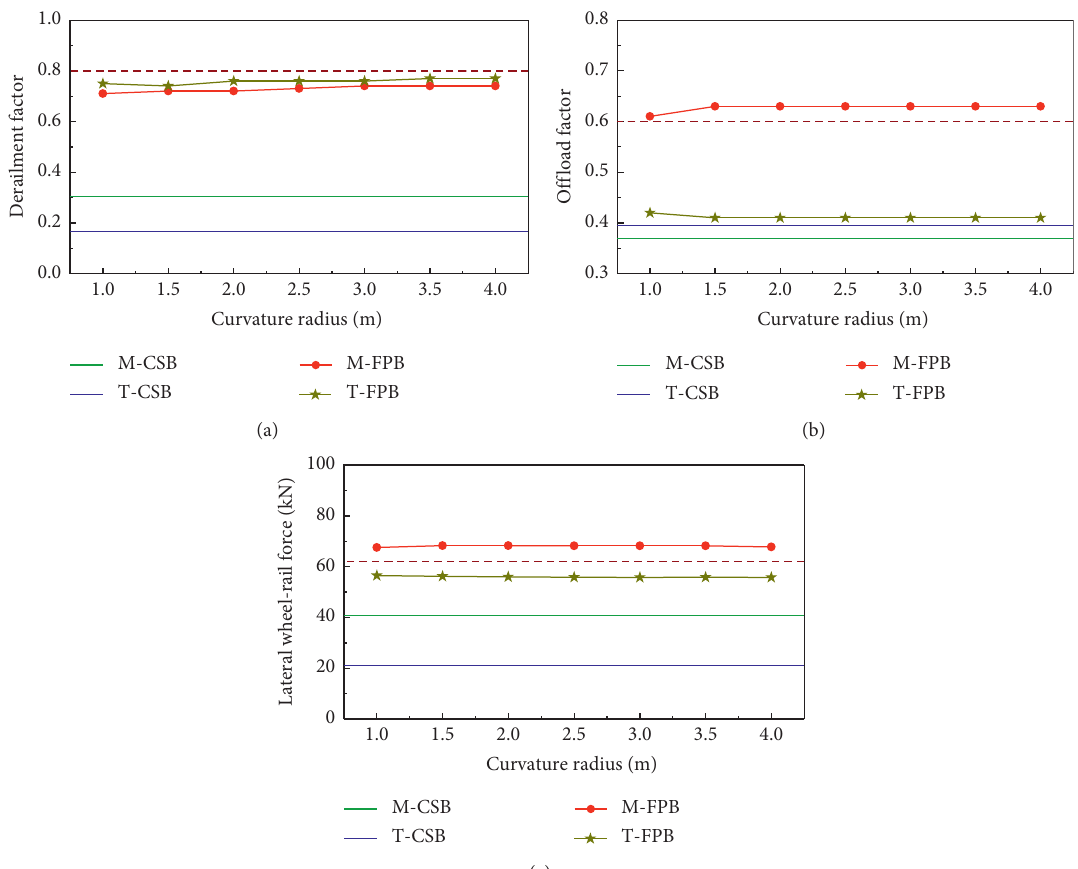
Figure 10: Distributions of running safety indices of the train versus curvature radius. (a) Derailment factor. (b) Offload factor. (c) Lateral wheel-rail